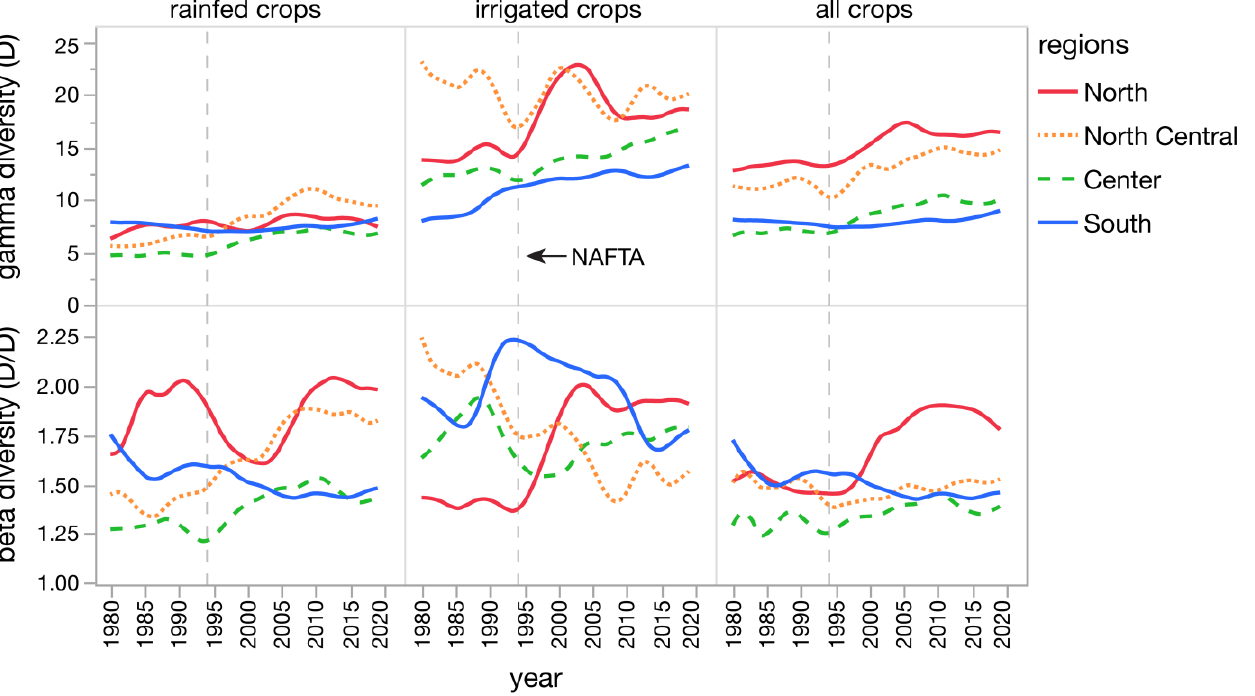
Figure 6. Changes in regional-level effective crop species diversity (D) among rainfed crops, irri- gated crops, and all crops. Here, gamma diversity expresses total D in each region (North, North Central, Center, South), and beta diversity expresses dissimilarity in D among the states in each region. The dashed line marks implementation of the North American Free Trade Agreement (NAFTA) in 1994.